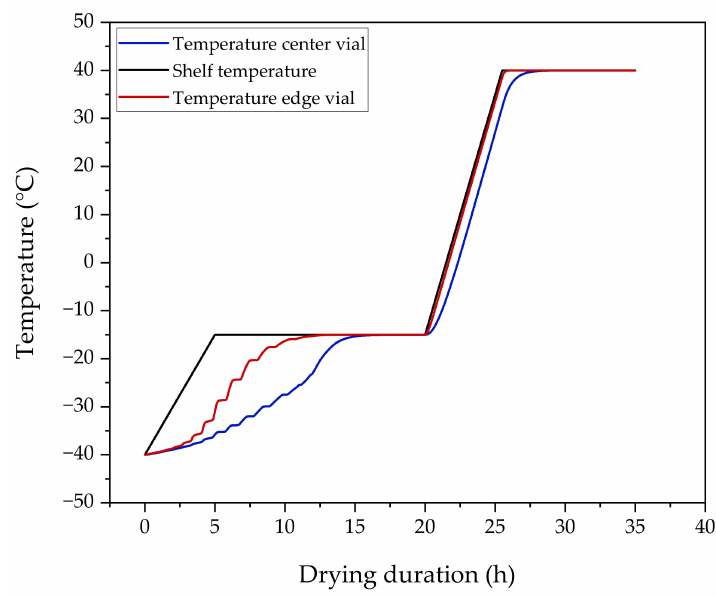
Figure 11. Shelf and product temperature